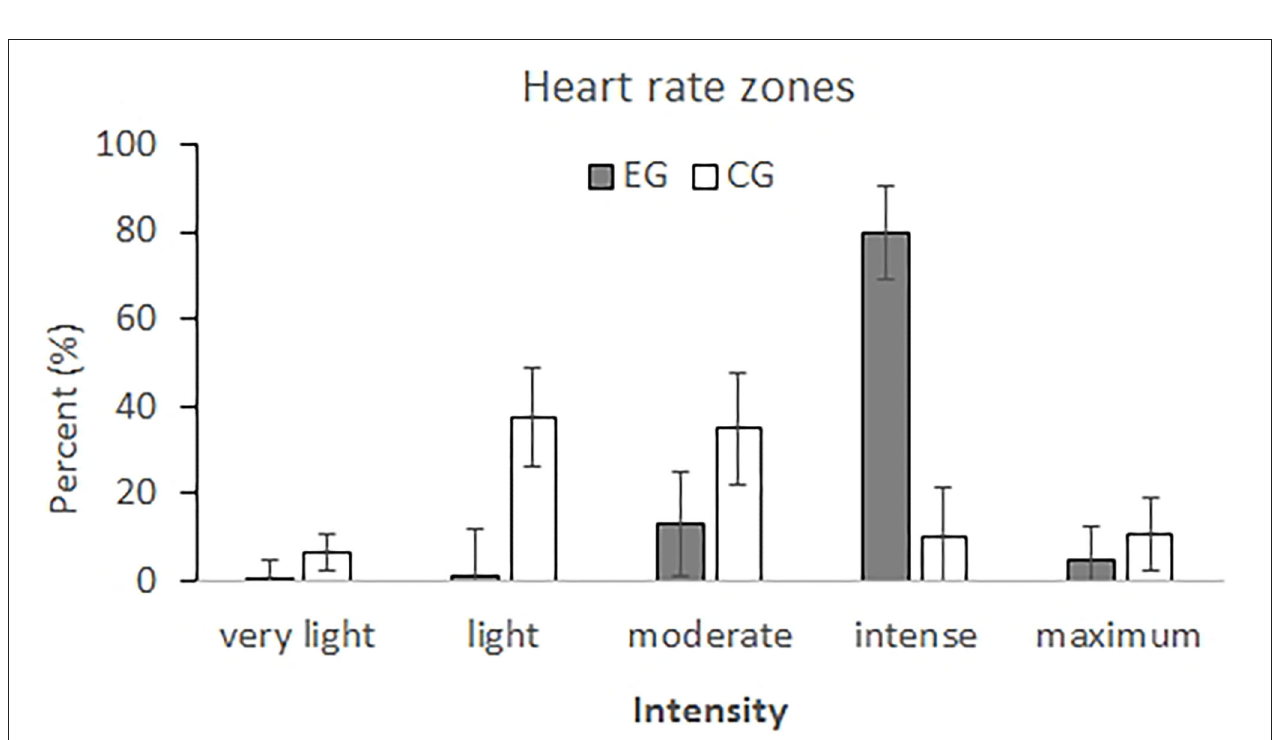
FIGURE 3 | Time (in percent) students of the experimental (EG, gray bars) and control group (CG, white bars) were running at very light (50–60% of maximum heart rate), light (60–70%), moderate (70–80%), vigorous (80–90%), and maximum intensities (90–100%) during the 30min run. Error bars indicate 95% CI.